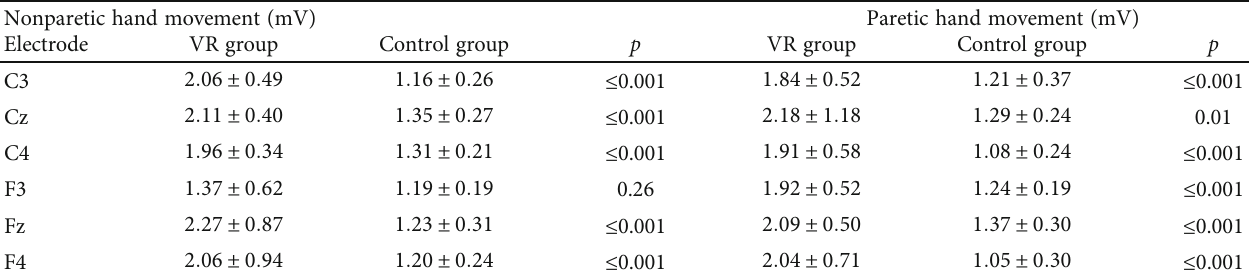
Table 4: Changes in CNV amplitude in the VR and control groups during nonparetic hand and paretic hand movements. Nonparetic hand movement (mV) Paretic hand movement (mV) Electrode VR group Control group VR